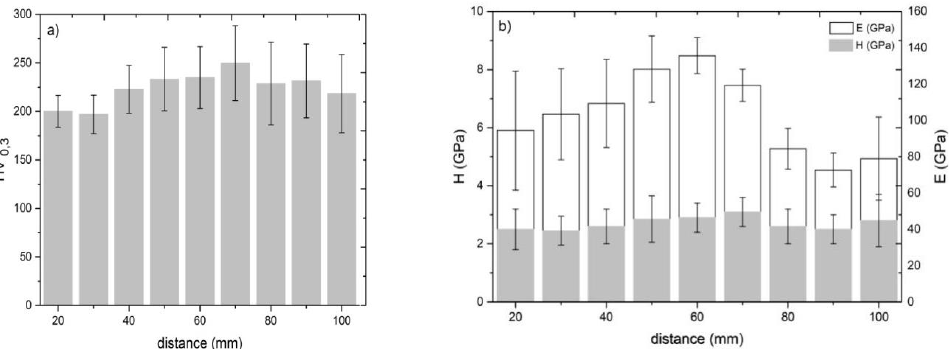
Figure 7. Effect of the standoff distance on: ( a ) microhardness, ( b ) nanohardness, and elastic modulus. Most measurement results show a high standard deviation because the microstructure of cold-sprayed coatings consists of particles differing in their degree of